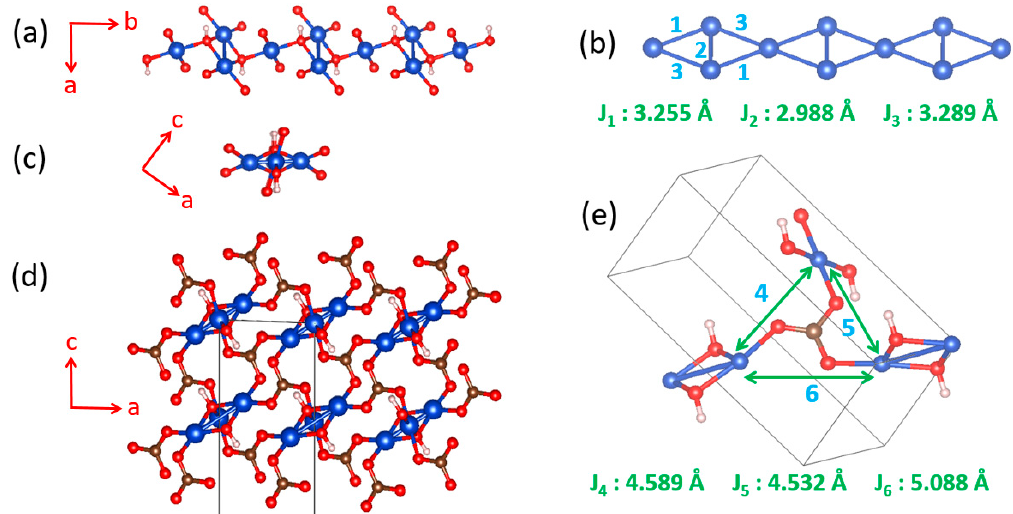
Figure 20. ( a ) The diamond chain made up of CuO 4 square planar units. ( b ) Definition of the three spin exchanges J 1 –J 3 in a diamond chain. ( c ) A projection view of the diamond chain along the chain direction. ( d ) The structure of Azurite viewed along the diamond chain direction. ( e ) Definition of the three spin exchanges J 4 –J 6 between adjacent diamond chains.